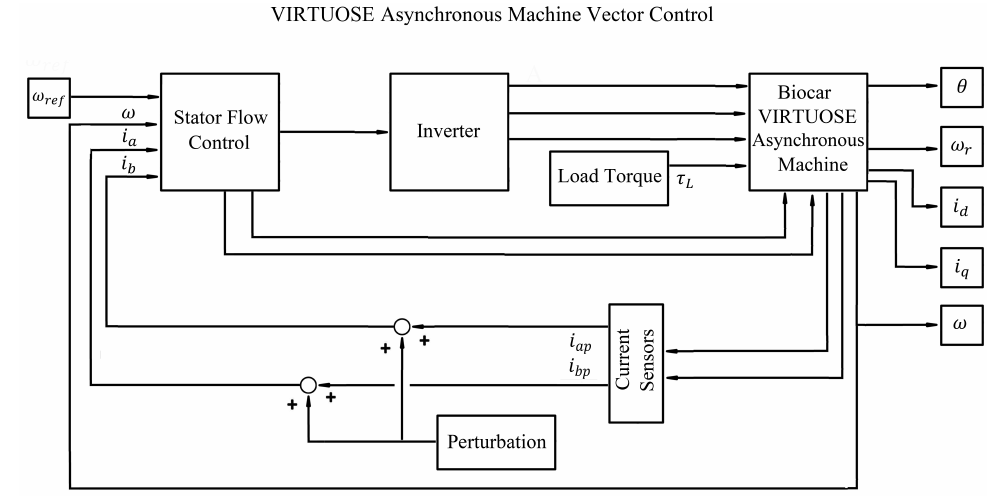
Figure 8. Simulation of the EV with Matlab/Simulink.